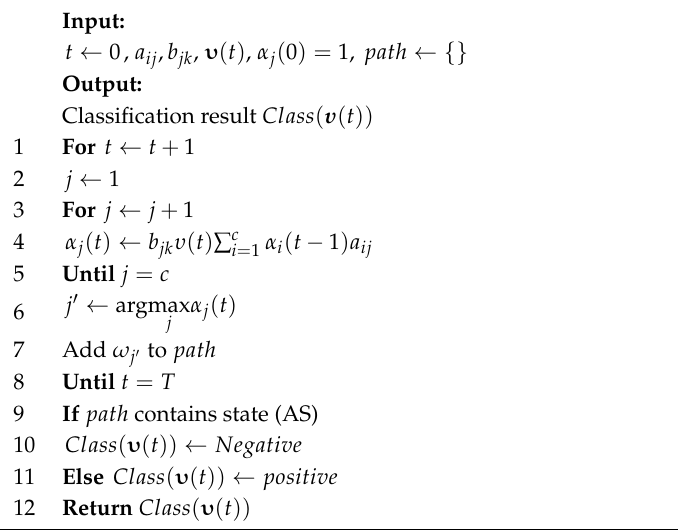
Algorithm 3. Anomaly detection based on the decoding strategy.